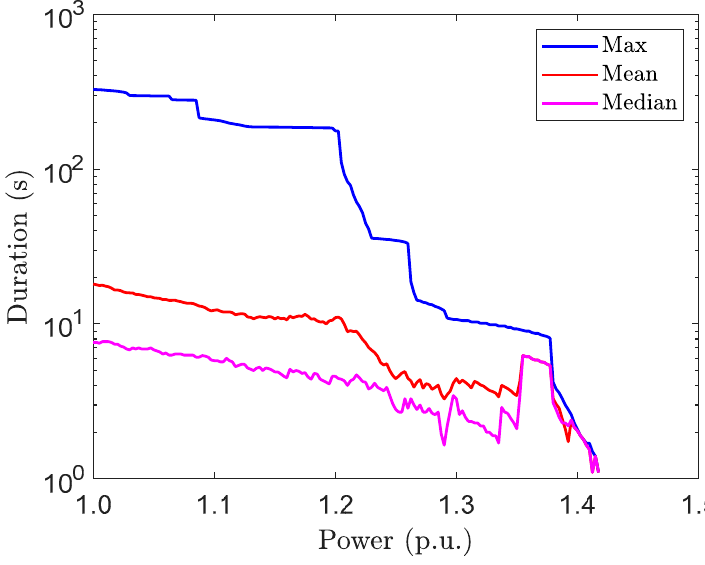
Figure 8. Maximum, mean, and median durations of overpower events caused by overirradiance events exceeding the power value. events exceeding the power